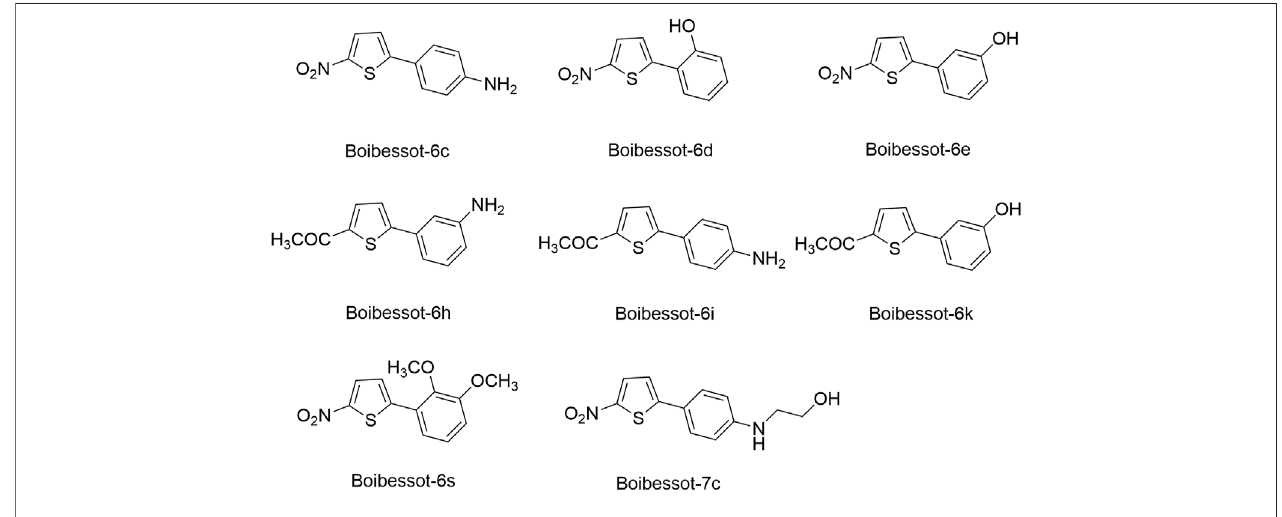
FIGURE 8 | The chemical structures of thiophene derivatives.